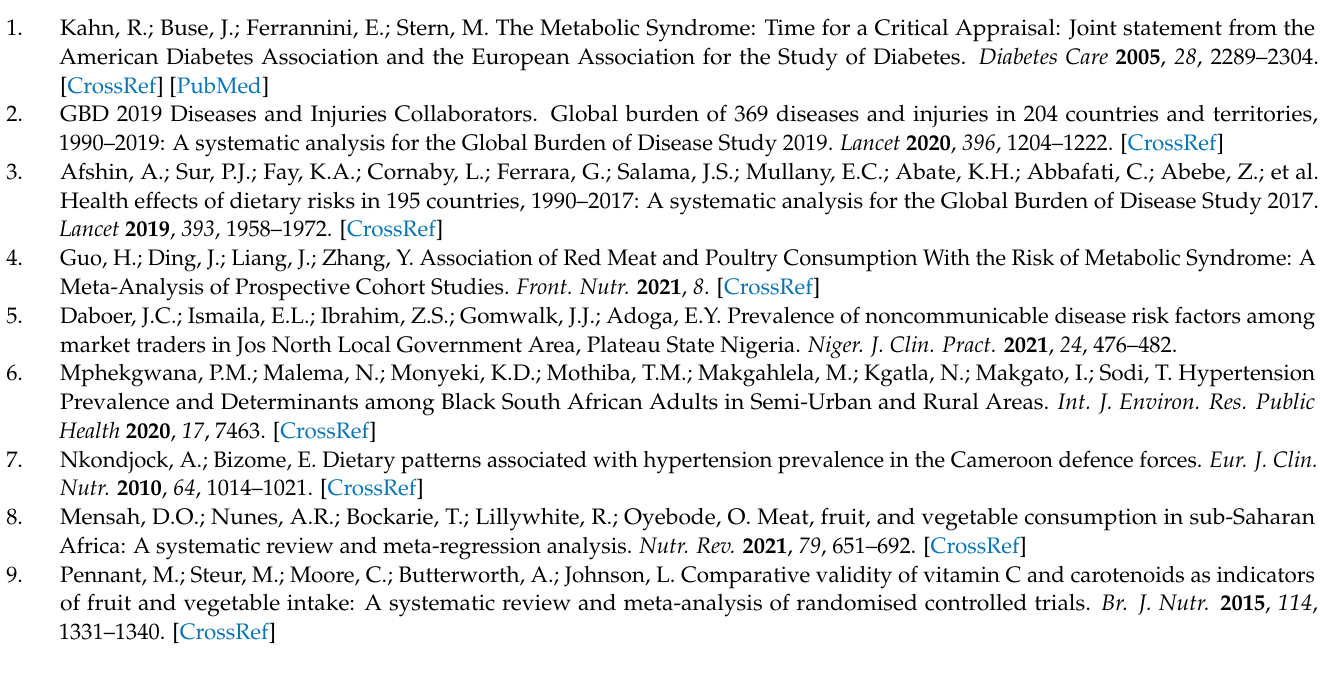
Table S2: Metabolic characteristics of the study population stratified by sex and urban/rural residence, Cameroon study ( n = 578); Table S3: Characteristics of participants with vitamin B12 and folate deficiency, Cameroon study ( n = 547); Figure S1: Distribution of self-reported fruit and vegetables intake in rural and urban residents (Cameroon study, n = 578); Figure S2: Distribution of self-reported fruit and vegetables intake in women and men (Cameroon study, n = 578); Figure S3: Association between serum folate and metabolic syndrome score (Cameroon study, n = 520); Figure S4: Association between serum holotranscobalamin and metabolic syndrome score (Cameroon study, n =